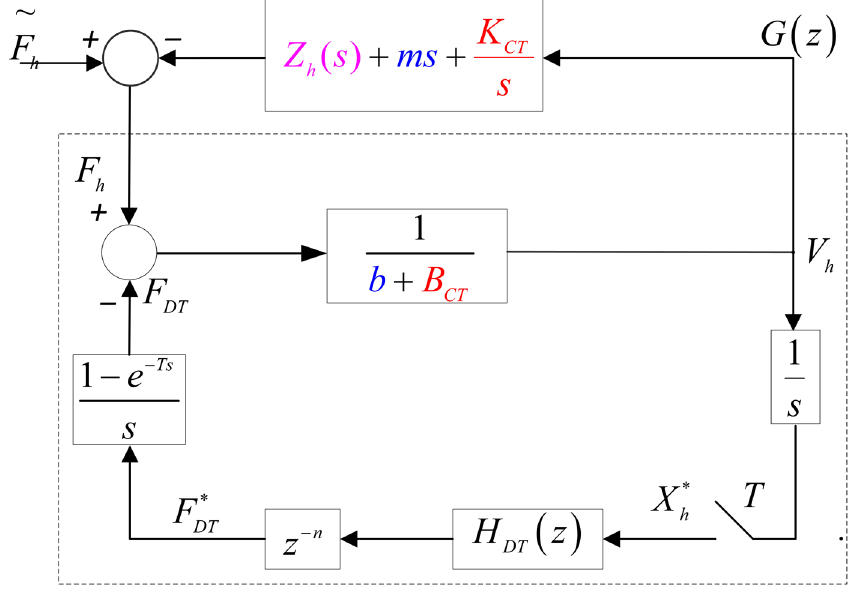
Figure 3. A model of single-user haptic virtual surgery simulation system under hybrid control.